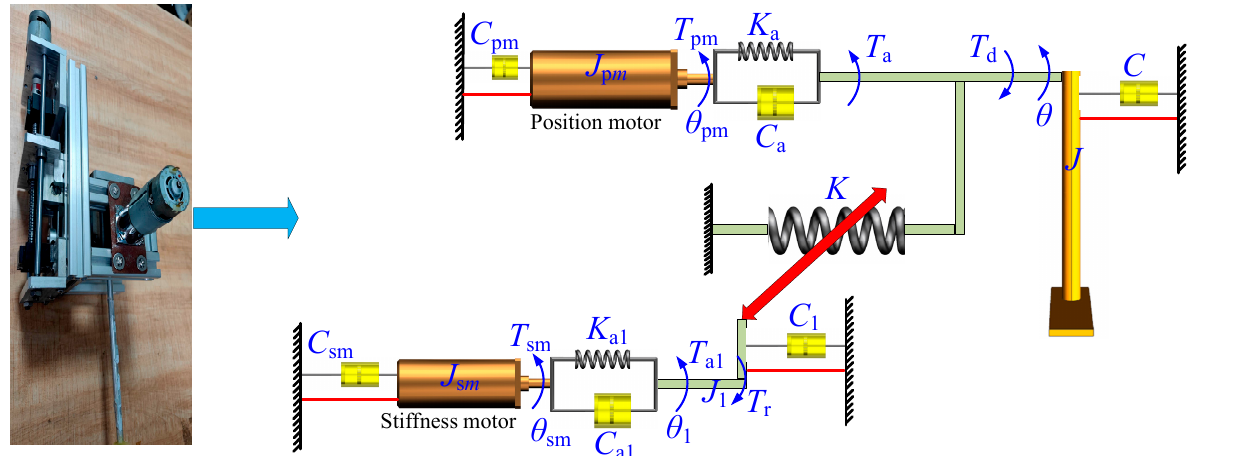
Figure 1. The schematic diagram of the two-inertia-system dynamics model of the variable stiffness actuator.